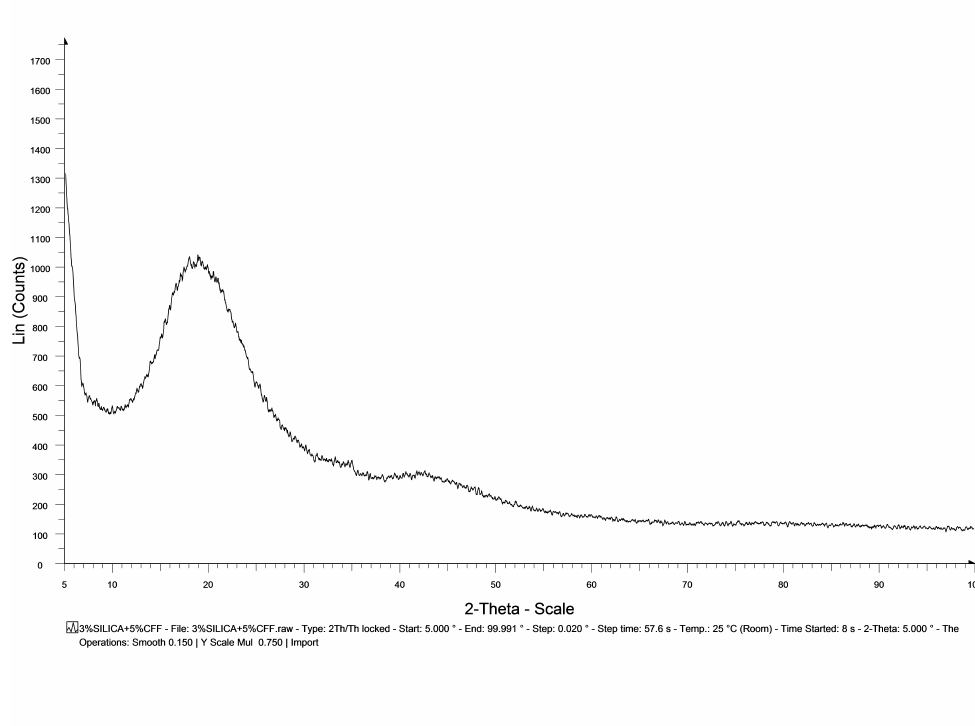
Figure 30: XRD for the sample containing 1.5 wt% CR and 5.0 wt% CFF.